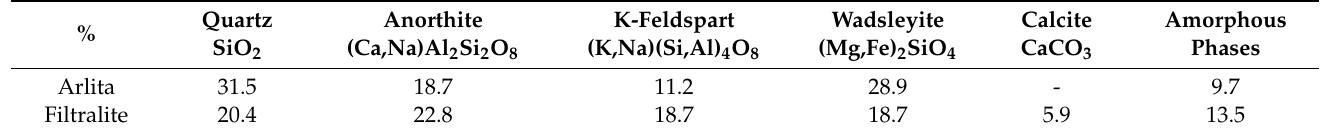
Table 1. Semiquantitative mineralogical composition of Arlita and Filtralite.